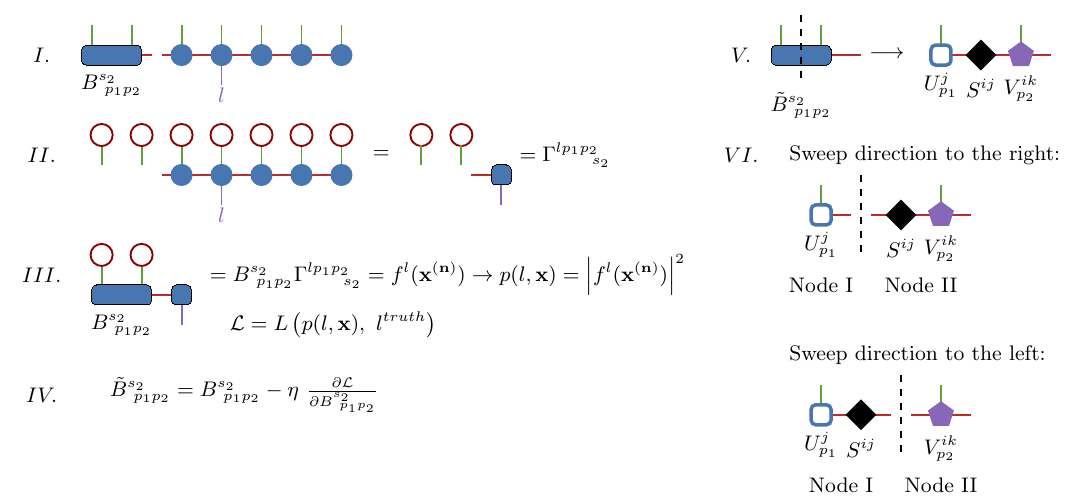
Figure 6 . Schematic representation of two-site DMRG-like algorithm used for updating tensor network. I–III shows the forward-pass where the loss function is calculated and IV - VI shows the backpropagation where two nodes of the MPS has been updated using gradient decent and splitted back into its original two node structure via